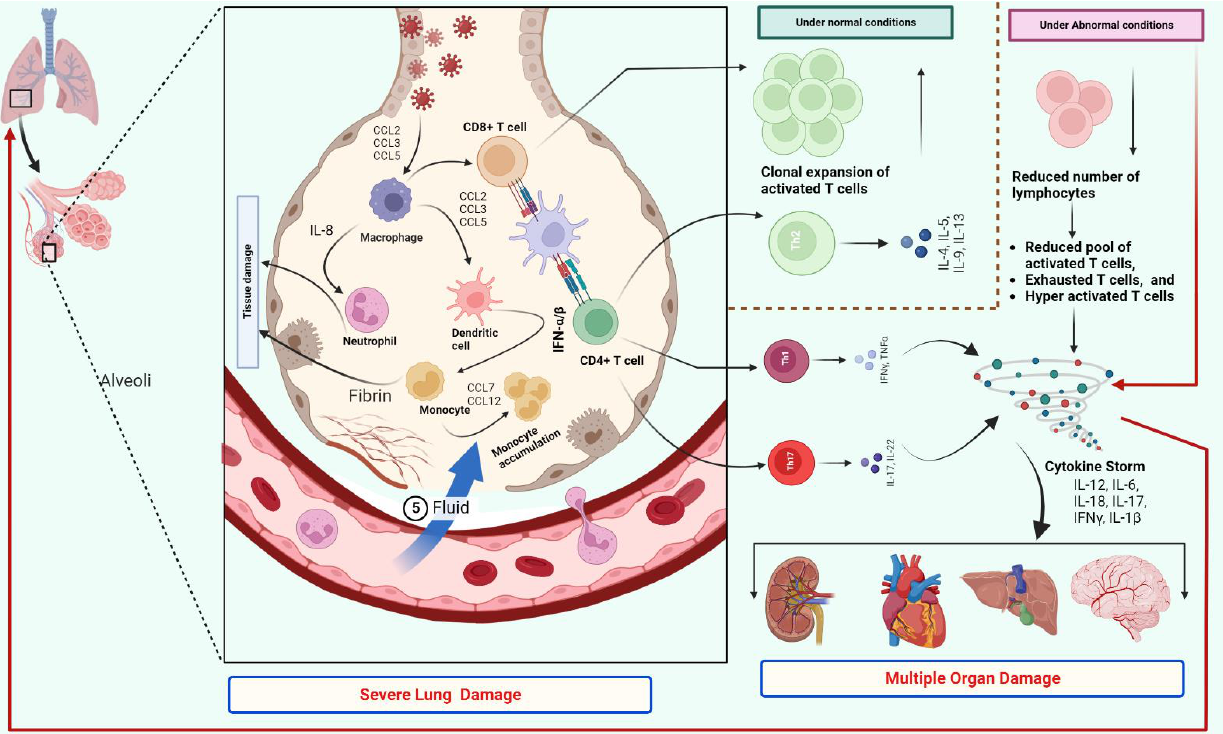
Figure 2. The association of the T cells with the excessive release of cytokines, disease severity, and ARDS. The expression of the ACE2 receptor on lymphocytes, particularly T cells, facilitates SARS-CoV-2 entrance into lymphocytes. During a mild infection or low viral load, the T cell number remains normal, and possibly normal functioning of the Th2 type cells will not lead to excessive inflammation and normal clonal expansion of T cells. However, under the severe form of the infection, monocyte accumulation and excessive antigen presentation lead to an increase in pro-inflammatory cytokine levels concurrently, causing T cell depletion and fatigue. Importantly excessive activation of Th1 and Th17 type T cells lead to increased levels of cytokines, importantly IL-6. Severe infection causes lymphopenia by directly affecting lymphatic organs such as the spleen and lymph nodes. The further figure represents various pathways for the excessive release of cytokines. Firstly, CD4+ T cells may be stimulated quickly into Th1 cells that secrete GM-CSF, generating CD14+CD16+ monocytes with high IL-6 levels. Secondly, an increase in the CD14+ IL-1+ monocyte subpopulation stimulates the production of IL-1. Additionally, Th17 cells generate IL-17, which recruits more monocytes, macrophages, and neutrophils while also stimulating other cytokine cascades, such as IL-1 and IL-6. This can lead to tissue damage and excessive accumulation of fluid in the lung, which in turn leads to multiple organ damage.